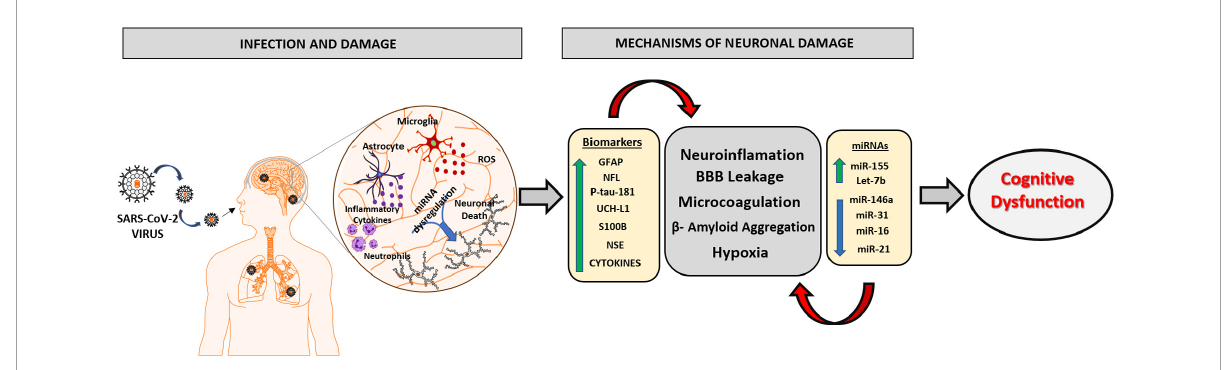
FIGURE3 Schematic representation of the main mechanisms involved in the neurophysiology caused by SARS-CoV2 virus and the role of biomarkers and miRNAs in neuronal damage. The SARS-CoV2 virus has the ability to infect brain tissue by mechanisms involving the olfactory and hematological pathway, which will lead to an oxidative and inflammatory state in nervous tissue, due to the activation of neutrophils, astrocytes, and microglial cells releasing excessive ROS and pro-inflammatory molecules. The imbalance in brain homeostasis leads to a dysfunction in the expression pattern of different biomarkers and miRNAs, potentiating neuroinflammatory mechanisms, responsible for brain damage and the consequent progression of cognitive dysfunction and neurodegenerative disorders. GFAP, Glial fibrillary acid protein; NFL, Neurofilament light chain; P-tau-181, Phosphorylated tau at threonine-181; UCH-L1, Ubiquitin Carboxy-Terminal Hydrolase L1; S100B, S100 calcium-binding protein B; NSE, Neuron Specific